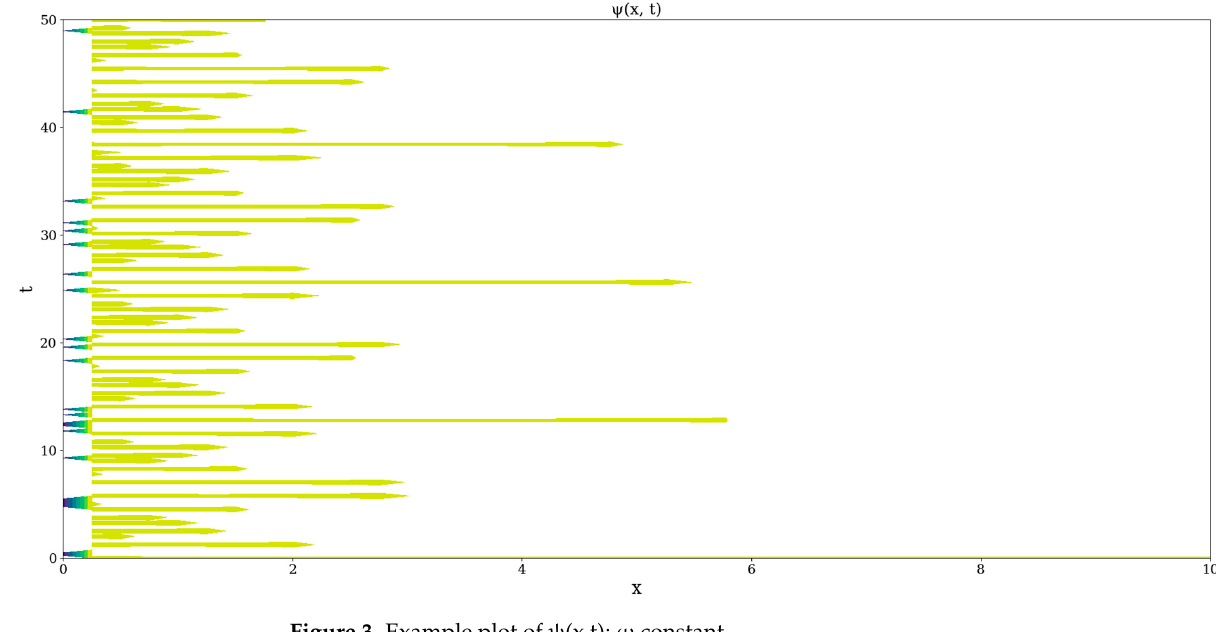
Figure 3. Example plot of ψ(x, t) ; ω constant.